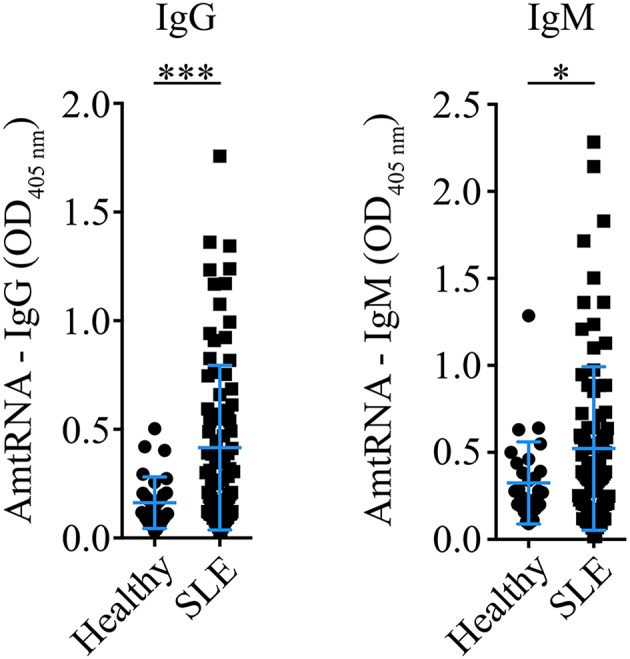
Antibodies targeting mitochondrial RNA (AmtRNA) are elevated in SLE patients. Two different isotypes of antibodies against mtRNA, IgG (left panel) and IgM (right panel), were assessed in SLE patients and healthy individuals included in the SARD-BDB. Both AmtRNA IgG and IgM were significantly increased in SLE patients, compared to healthy individuals (p = 0.0002 and p = 0.0493, respectively). SLE: N = 86; Healthy controls: N = 30. Data show the mean ± SD. Student's t-test. *p < 0.05; ***p < 0.001.